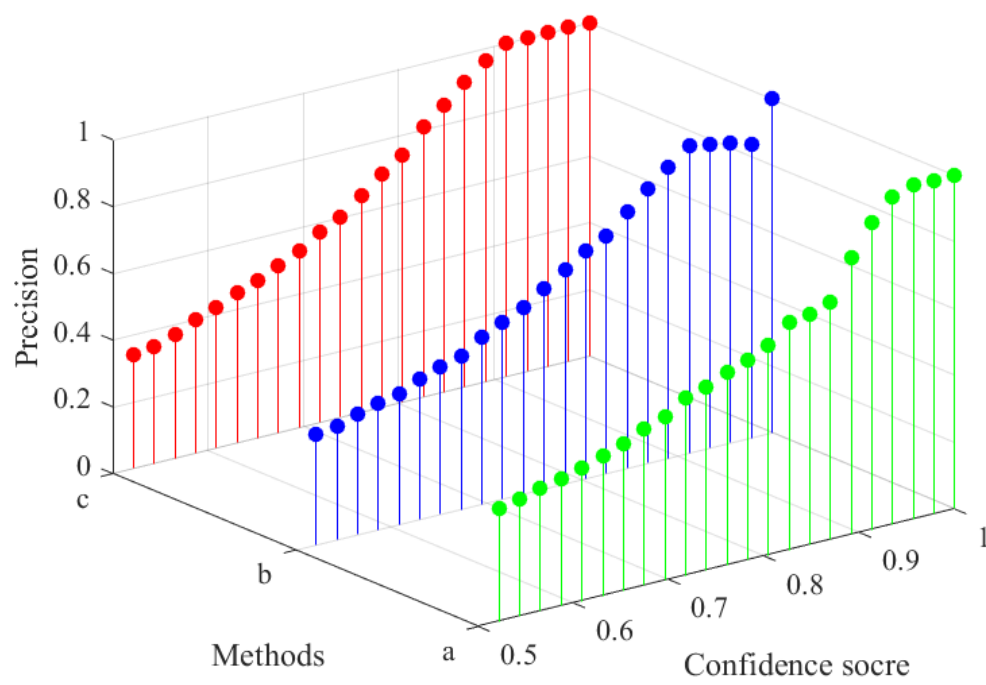
Figure 8. Ship detection precision (%) versus confidence score for different detection methods. ( a ) YOLOv4, ( b ) Faster RCNN, and ( c ) our